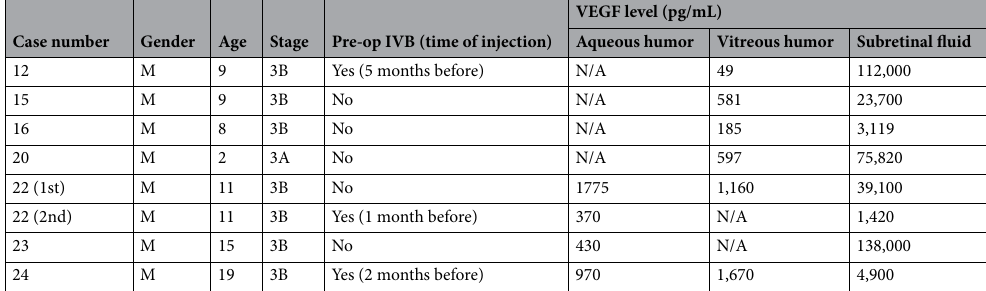
Table 4. Intraocular VEGF levels associated with intravitreal injection of bevacizumab. op; operative; IVB, intravitreal injection of bevacizumab; VEGF, vascular endothelial growth factor; M male; m, month; N/A, not